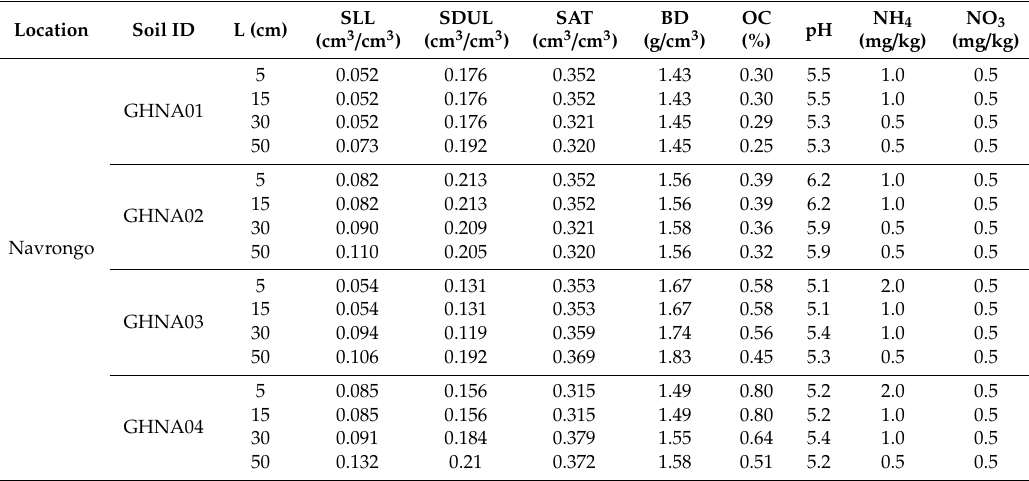
Table 2. Soil parameters used in simulations for the Navrongo and Tamale,